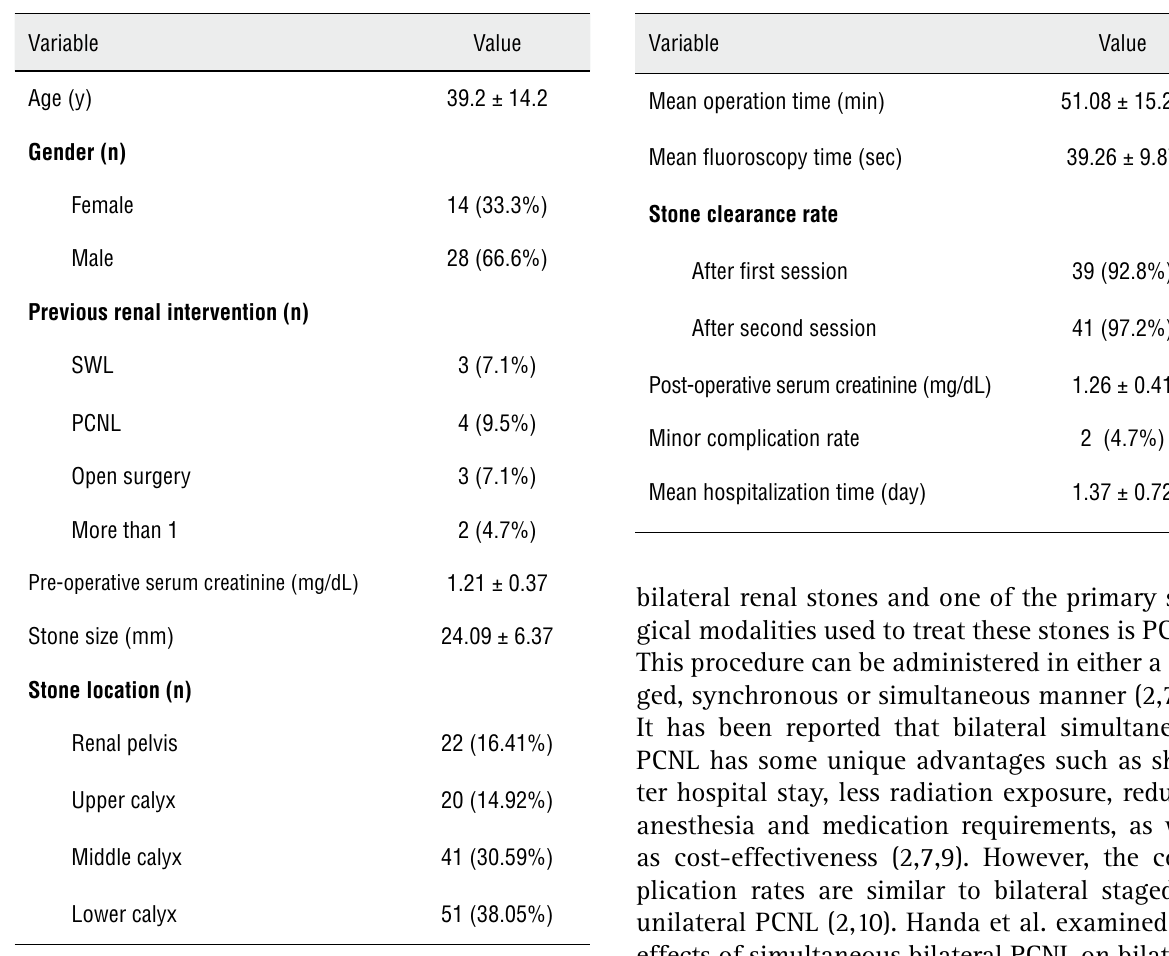
Table 2 - Operative and postoperative outcomes. Table 1 - Patient and Stone